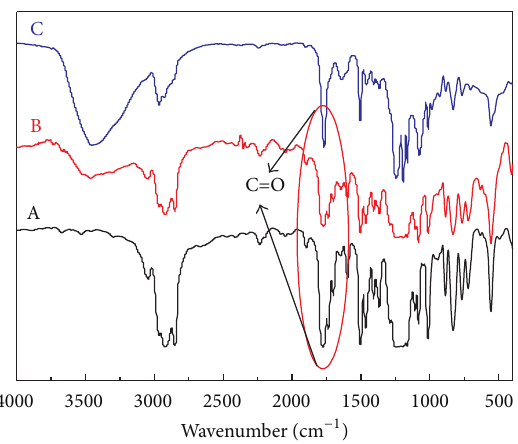
Figure 1: Spectrums of PC/PLA/TPU blends (A: PC/PLA/TPU (70/30/10); B: PC/PLA/TPU (70/30/30); C: PC/PLA/TPU/DBTO